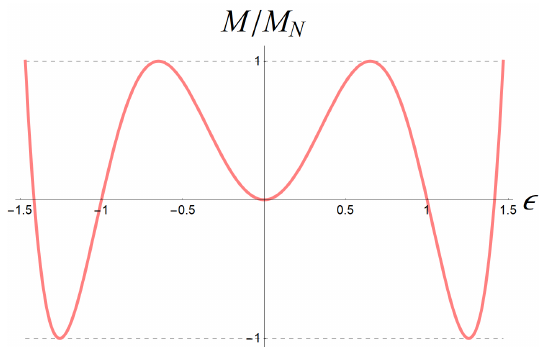
Figure 9: Mass M in units of M (cid:112) 1 < | ε | < 2 the mass M becomes negative, and for | ε | > exceeds M . N